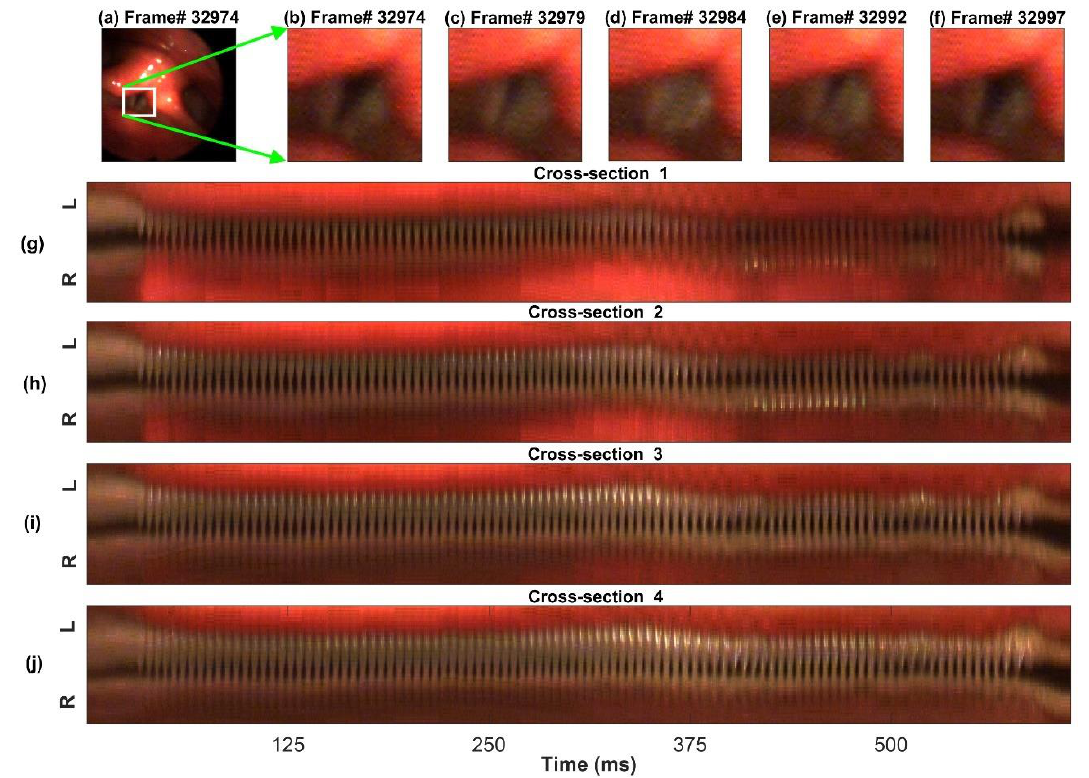
Figure 1. Panels ( b – f ): five HSV cropped frames for Frame 32,974, 32,979, 32,984, 32,992, and 32,997 after applying the motion window to five different HSV frames (one HSV frame is shown in Panel ( a )). Panels ( g – j ): four extracted kymograms at different cross-sections of the vocal folds. The R and L on the y -axis indicate the right and left vocal folds in the HSV frames, respectively.